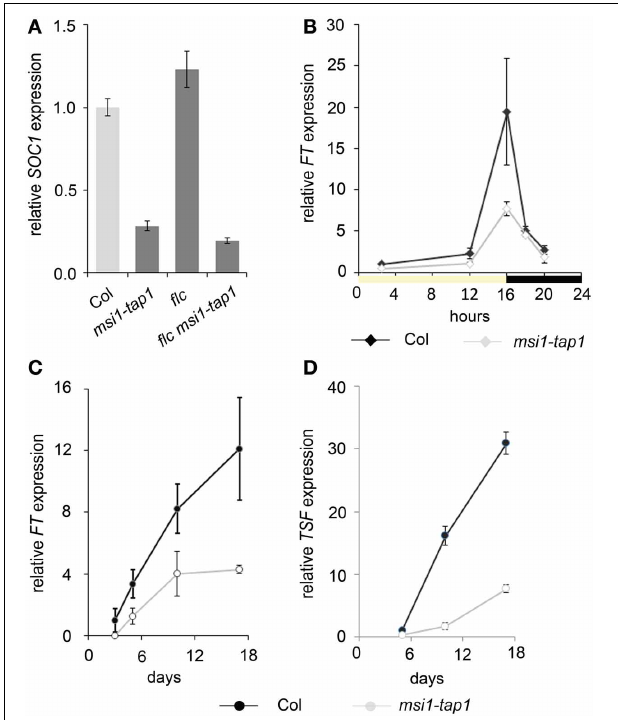
FIGURE 1 | Expression of SOC1, FT, and TSF is reduced in msi1-tap1 in LD. (A) SOC1 -expression in 9-day-old seedlings of Col (light gray), msi1-tap1 , flc, and flc msi1-tap1 (dark gray) in LD at EOD (end of day). (B) Diurnal expression pattern of FT in 10-day-old seedlings. X-axis represents hours after start of the light period (yellow box—light period, black box—dark period). (C,D) Gene expression kinetics of FT (C) and TSF (D) in Col and msi1-tap1 at the end of the day (EOD) at 5, 10, and 17 days after germination (DAG). Values are relative expression ± SE ( n = 3). Black lines, Col; gray lines, msi1-tap1